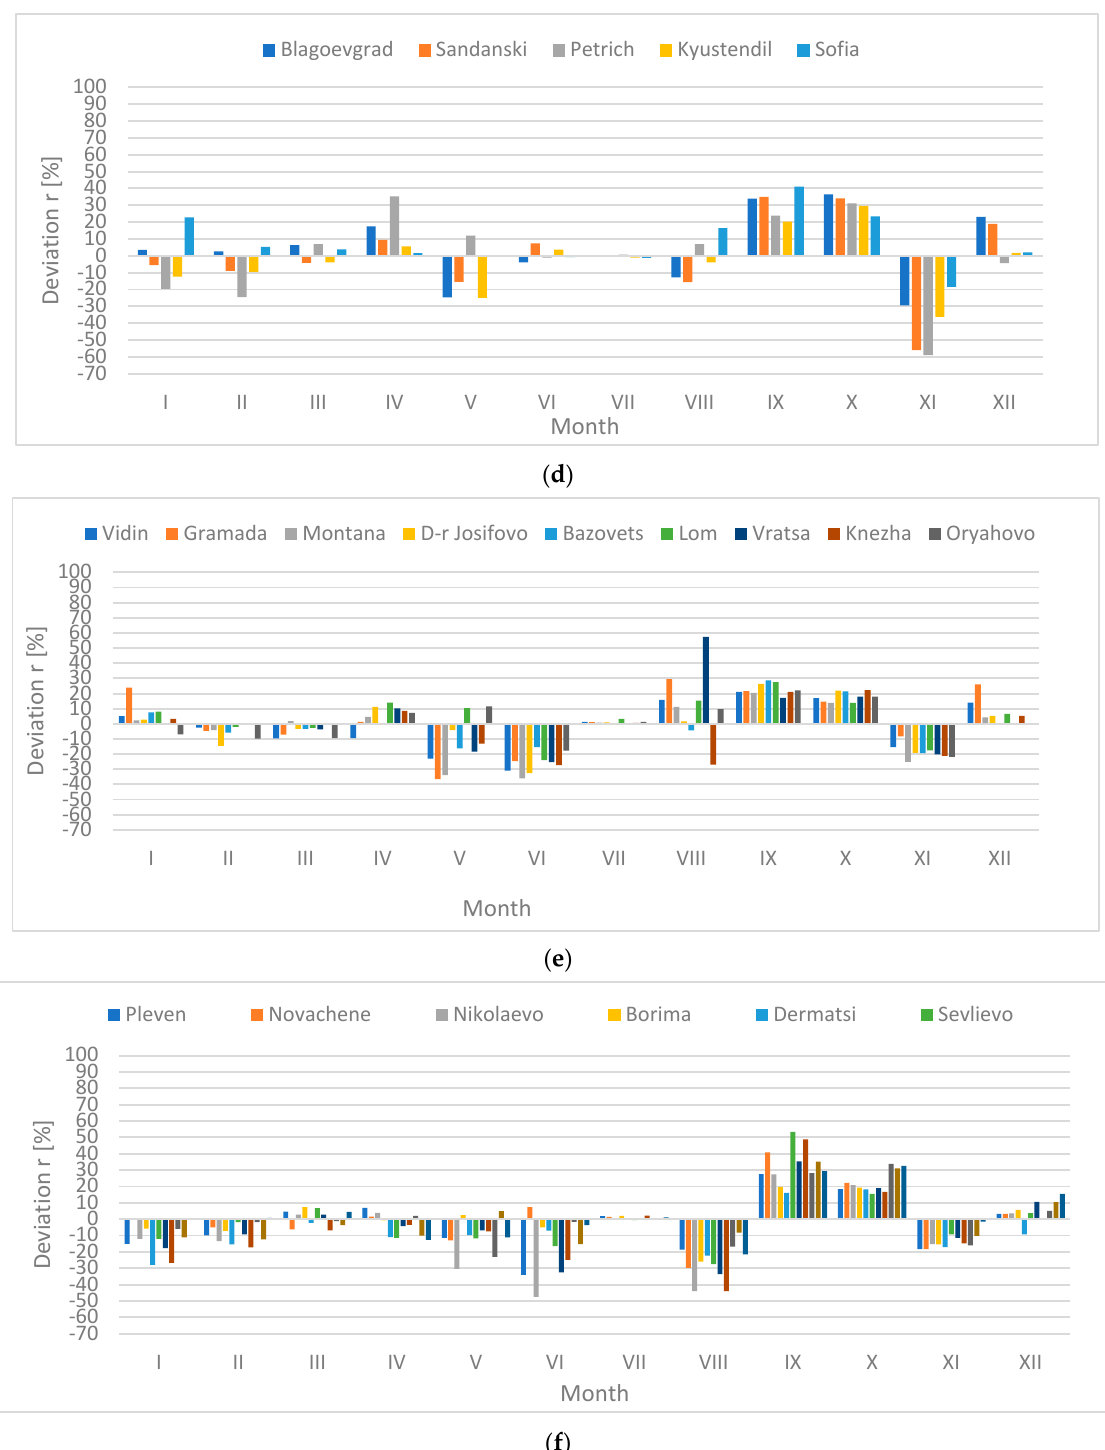
Figure 3. Deviations in the monthly sum of rainfall for the period 1986–2015 in ( a ) northeast, ( b ) southeast, ( c ) central south, ( d ) southwestern, ( e ) northwest and ( f ) central north Bulgaria compared to 1961–1990. Table 11. Average monthly sums of rainfall deviations in southwestern Bulgaria in the period 1986–2015. of the year—January—the average deviation varied between 0.5–1.5 ◦ C. In northwest